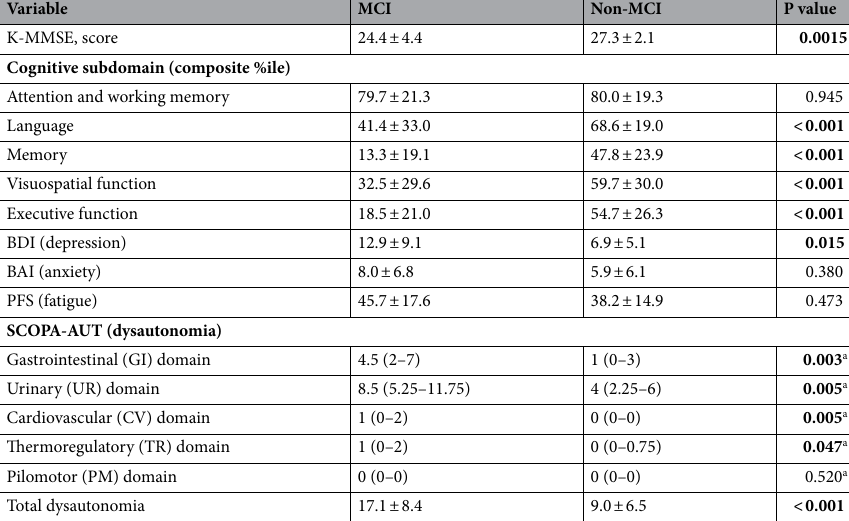
Table 2. Comparison of cognition and other non-motor symptoms in de novo Parkinsonian patients with or without MCI. Data are shown as mean ± S.D., or median (interquartile range) values. MCI, mild cognitive impairment; K-MMSE, Korean version of mini-mental state examination; BDI, Beck depression inventory; BAI, Beck anxiety inventory; PFS, Parkinson’s disease fatigue scale; SCOPA-AUT, the Scale for Outcomes in Parkinson’s disease-Autonomic questionnaire. Statistical analyses were conducted with Chi square test for categorical variables, and Student t-test or Mann–Whitney U test a for continuous variables. Significant values are in